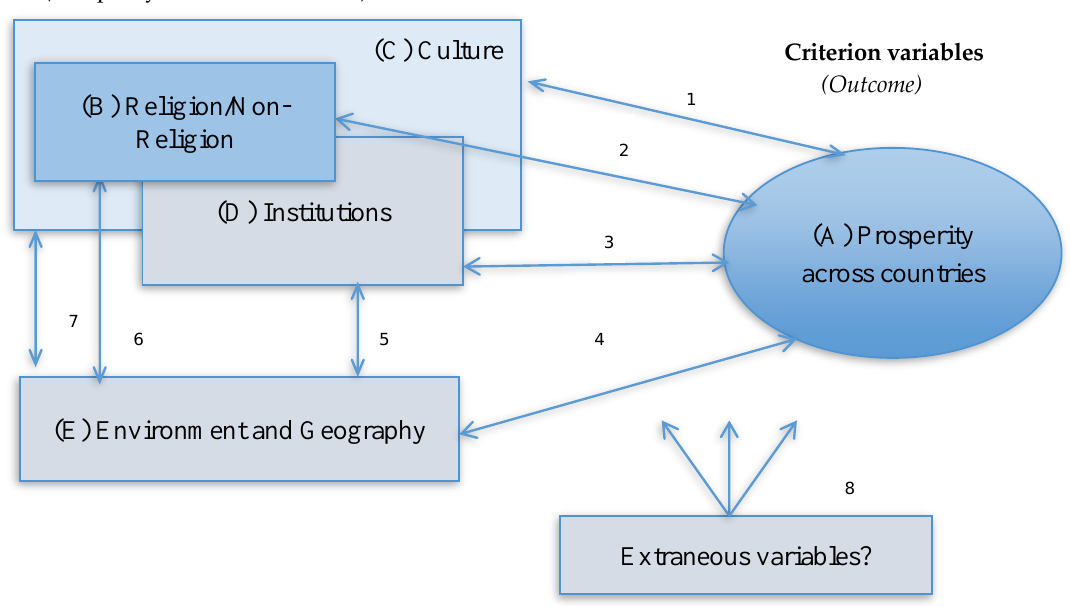
Figure 1. Research model of this study (Source: Author’s figure). Note: Arrows and numbers indicate potential causal relations, based on which prosperity (A), religion (B), and institutions (D) are theoretically explored in Sections 5 – 7.